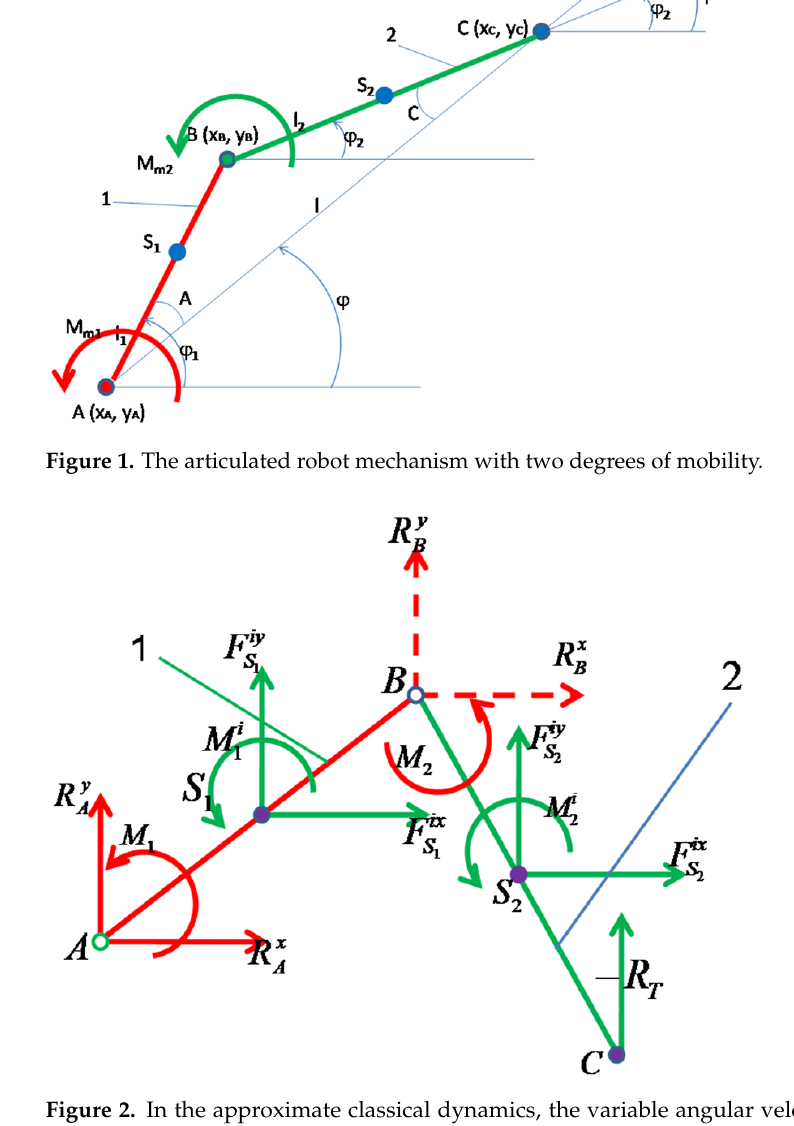
Figure 2. In the approximate classical dynamics, the variable angular velocities and the variable angular accelerations are determined; the variation is due to the forces of inertia.